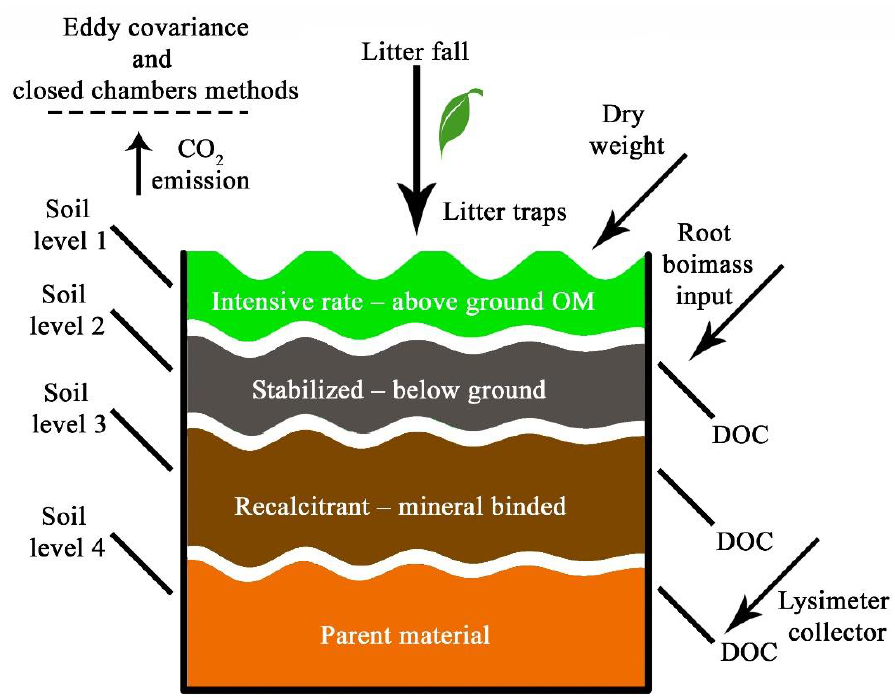
Figure 3. Schematic structure of carbon polygons functions and methods of carbon traps.